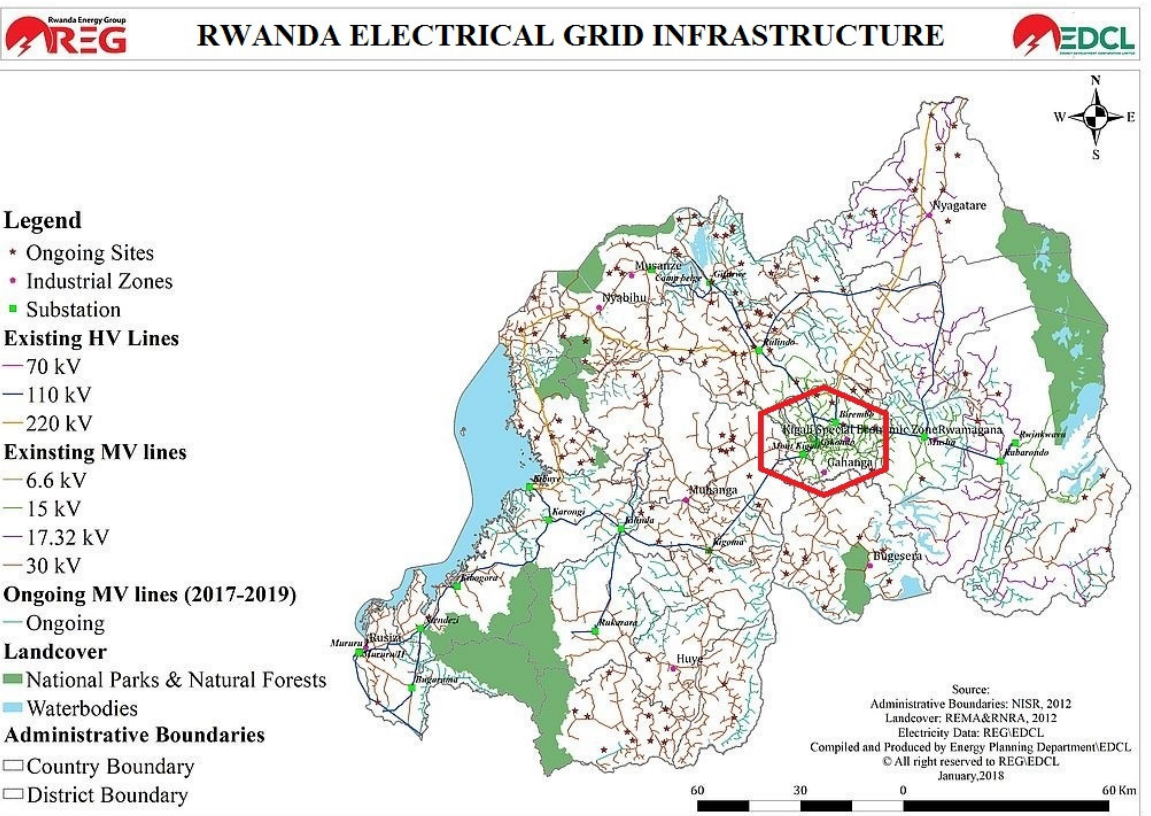
Figure 1. Estimated location of electricity transmission and distribution network. Source: REG [32]. Table 1. Number of components in system model.